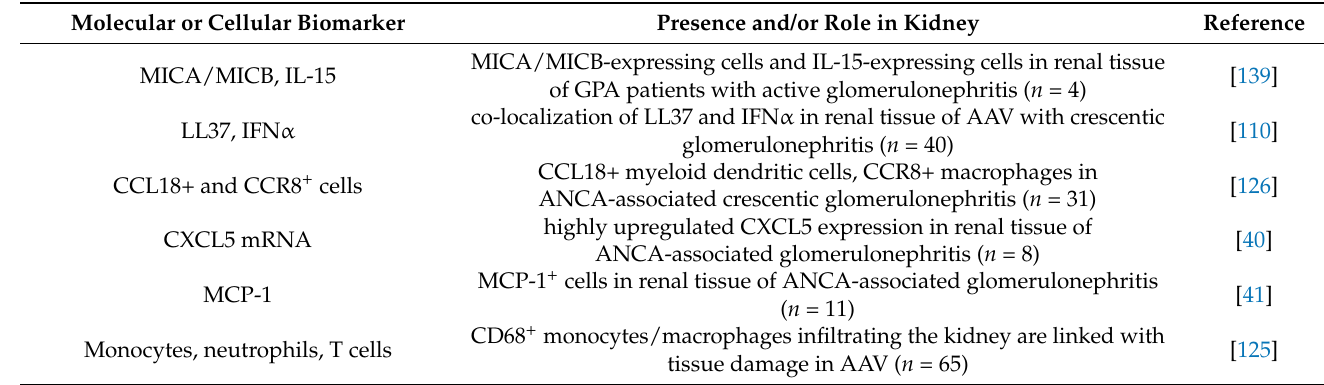
Table 2. Overview about potential molecular and/or cellular markers suggested to participate in inflammatory, au- toimmune, and destructive mechanisms in renal tissue of AAV patients (GPA, MPA, or MPO-AAV, respectively, ANCA- associated